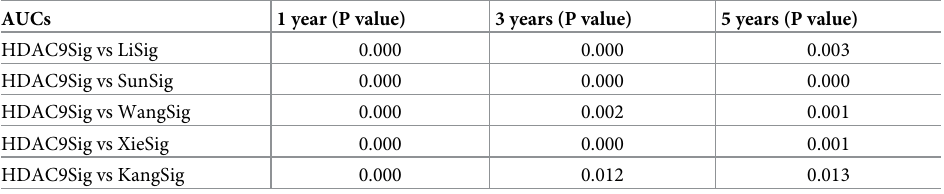
Table 5. Comparison of ROC curve AUCs between HDAC9-associated immune-related signature and other risk signatures based on other risk factors.